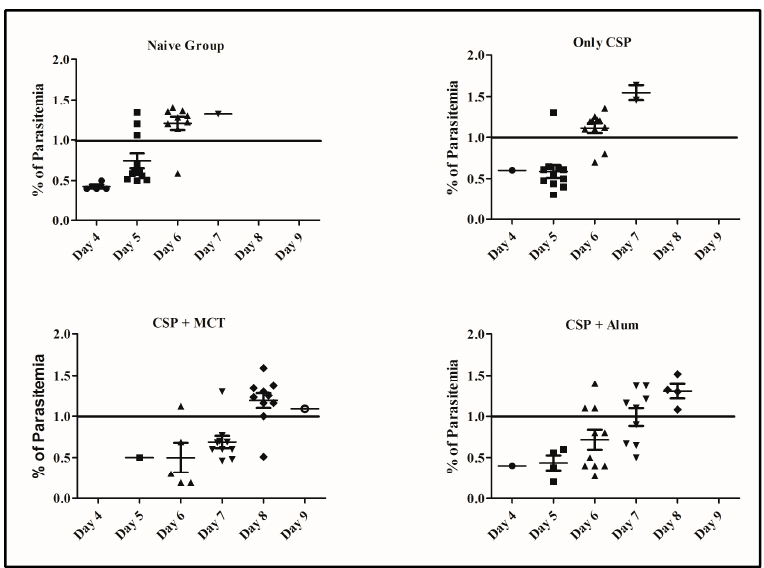
Figure 7. Percentage of erythrocyte infection at each time points for each group. Parasitemia levels were determined at individual time points and shown for each mouse from Figure 6. Several possibilities may exist to explain why MCT groups conferred better protection